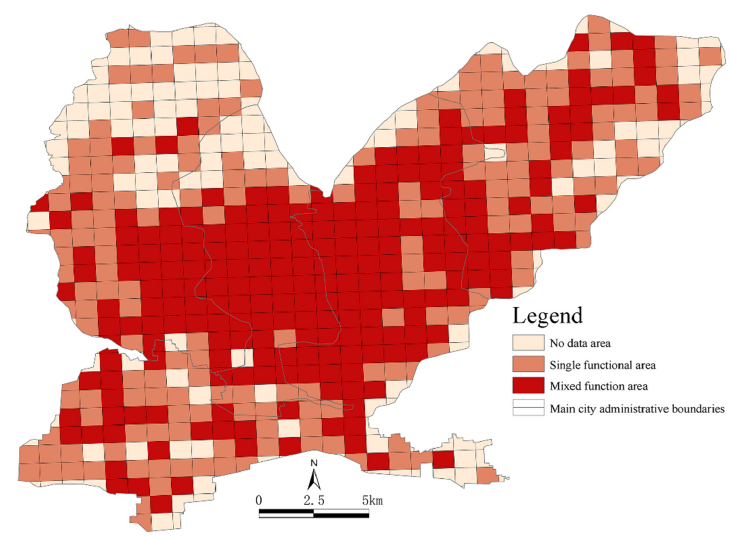
Figure 6. The spatial distributions of the urban functional units in the main urban area in